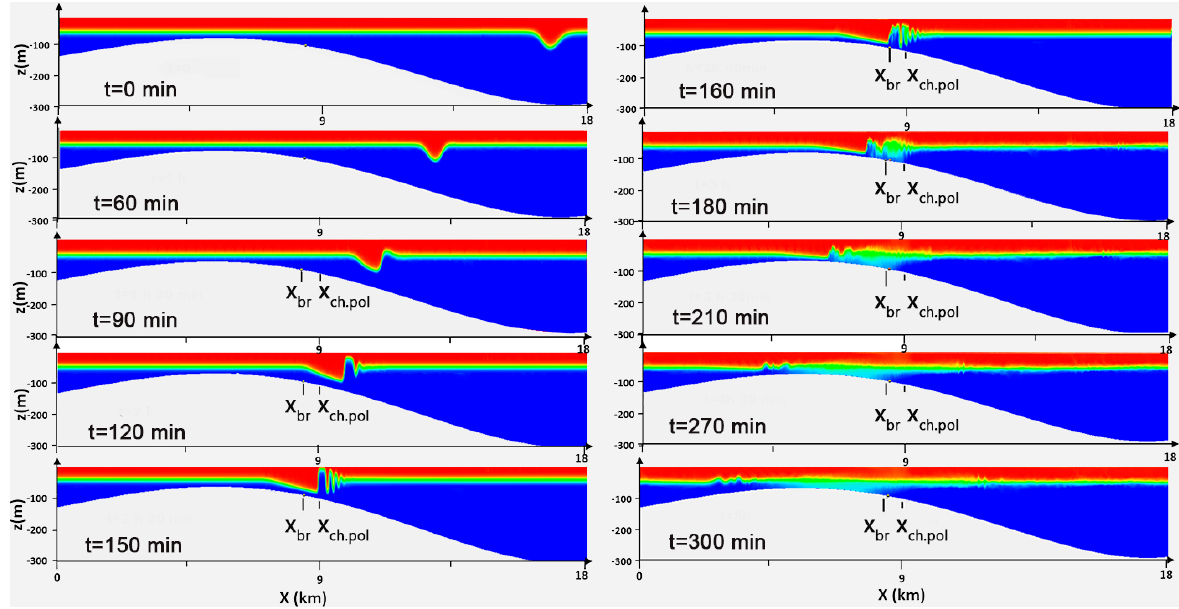
Figure 4. The evolution of an ISW with | a in | = 50m in cross sections at times t = 0, 60, 90, 120, 150, 160, 180, 210, 270 and 300min ( γ = 1 ◦ , α = 1, β = 0 . 4), respectively. x br and x ch . pol are the points of breaking and changing polarity, respectively.